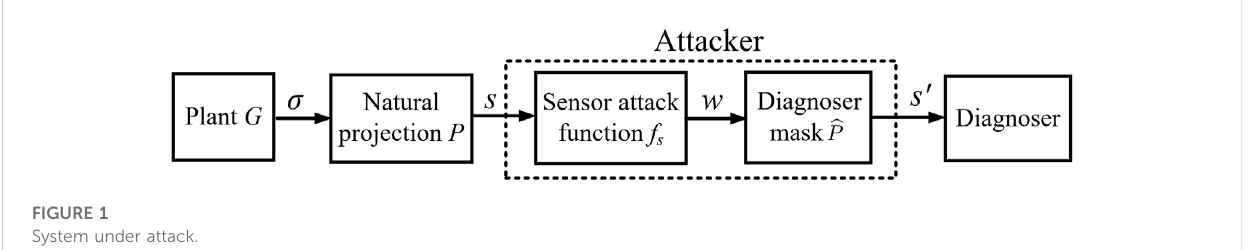
FIGURE 1 System under